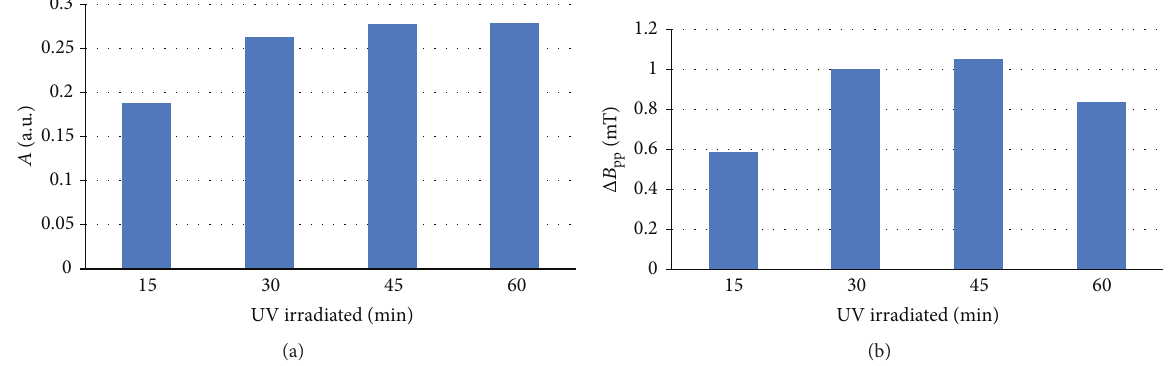
Figure 3: Comparison of (a) amplitudes ( 𝐴 ) and (b) linewidths ( Δ𝐵 pp ) of EPR spectra of salicylic acid after UV irradiation in different times.